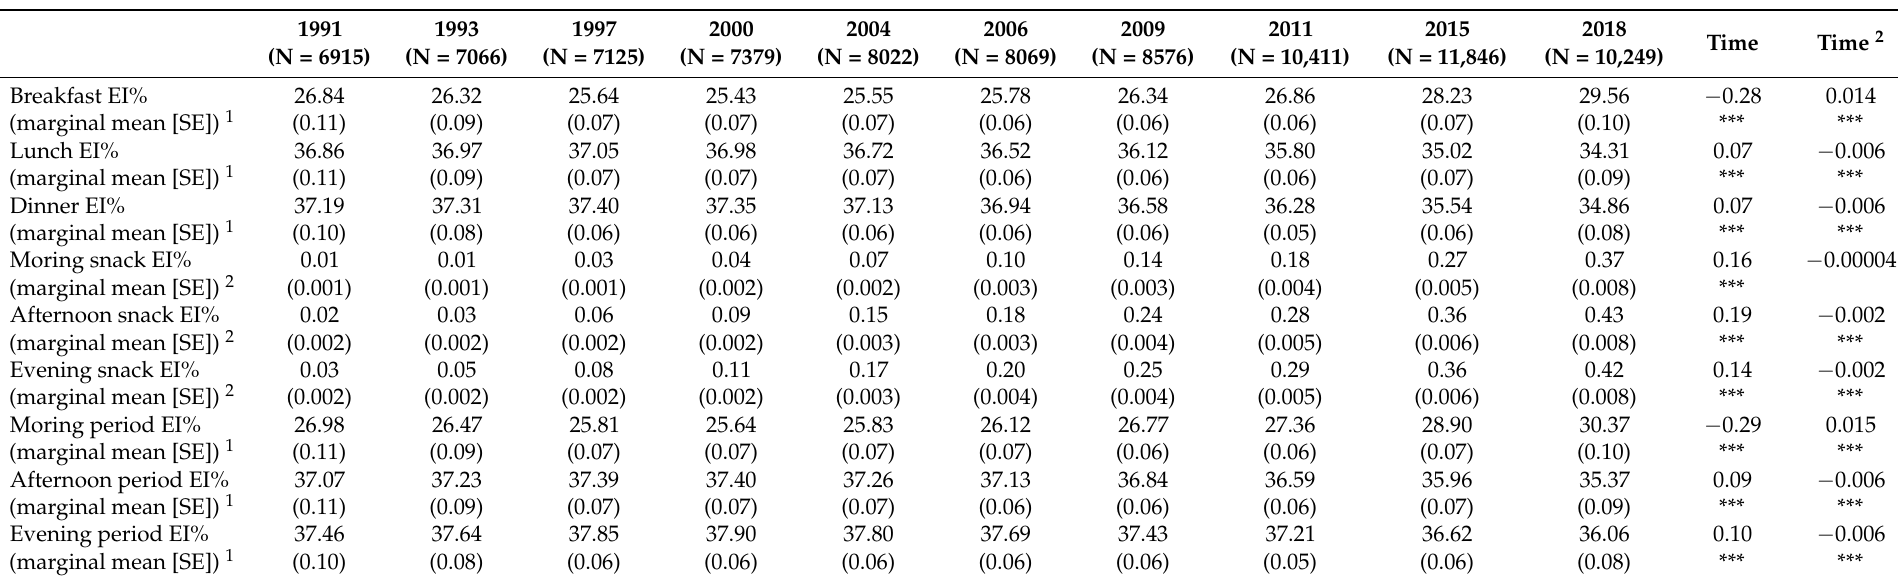
Table 2. Secular trends and marginal mean of energy proportions of eating occasions in study sample from 1991 to